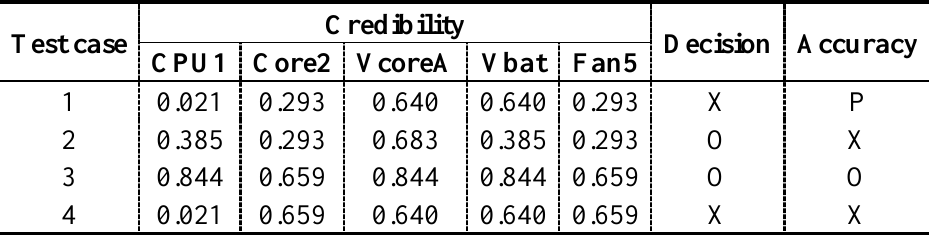
Table 11. Results of diagnostic model